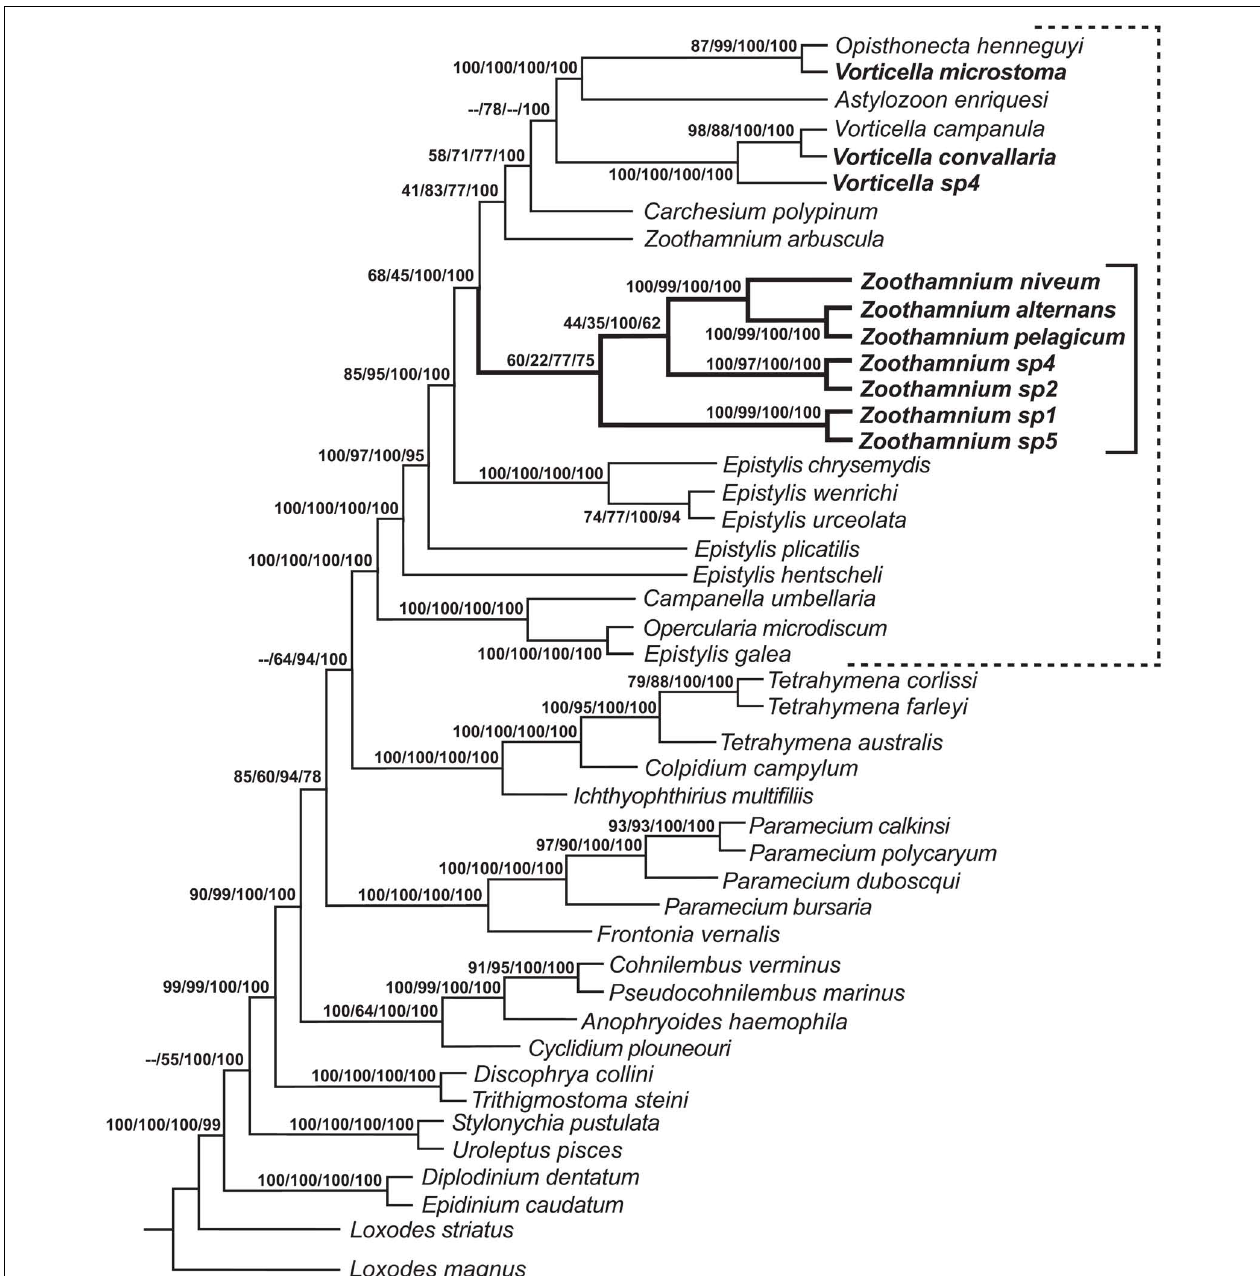
FIGURE 2 | Consensus tree formed from the four trees generated by phylogenetic analyses (Clamp andWilliams, 2006). Neighbor-joining (NJ) bootstrap value, maximum parsimony (MP) bootstrap value, maximum likelihood (ML) consensus value, and Bayesian consensus value are given as